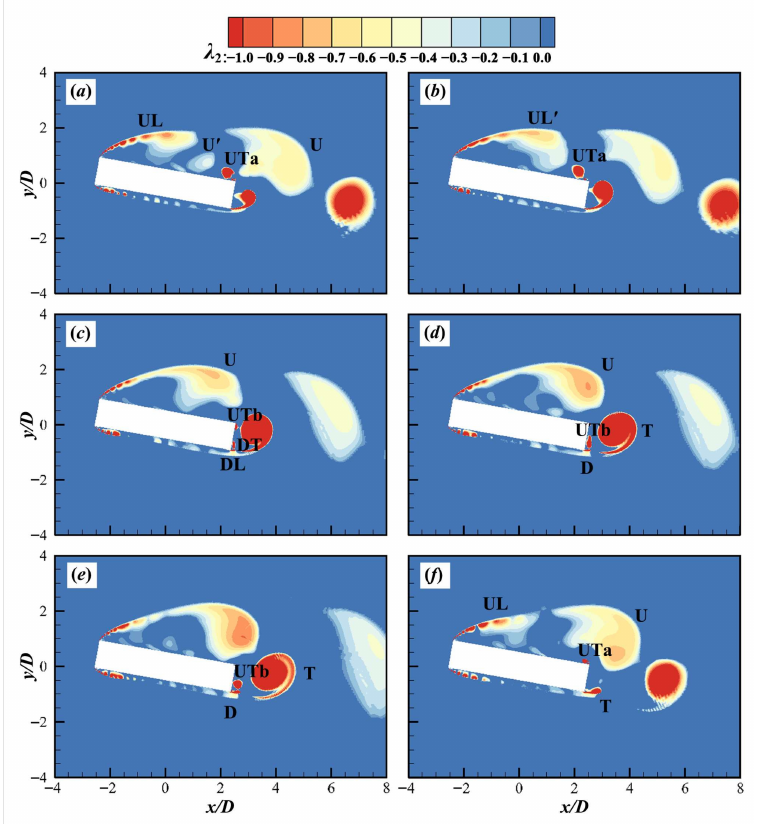
Figure 21. Vortex evolution within a vortex shedding period at α = 10 ◦ . ( a ) tU ∞ /D = 855.4, ( b ) tU ∞ /D = 856.4, ( c ) tU ∞ /D = 858.4, ( d ) tU ∞ /D = 859.9, ( e ) tU ∞ /D = 861.4, ( f ) tU ∞ /D = 863.4.